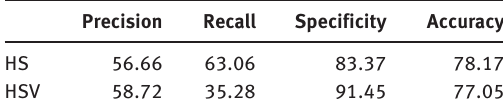
Table 2. Accuracy Results for HS and HSV on the UCD